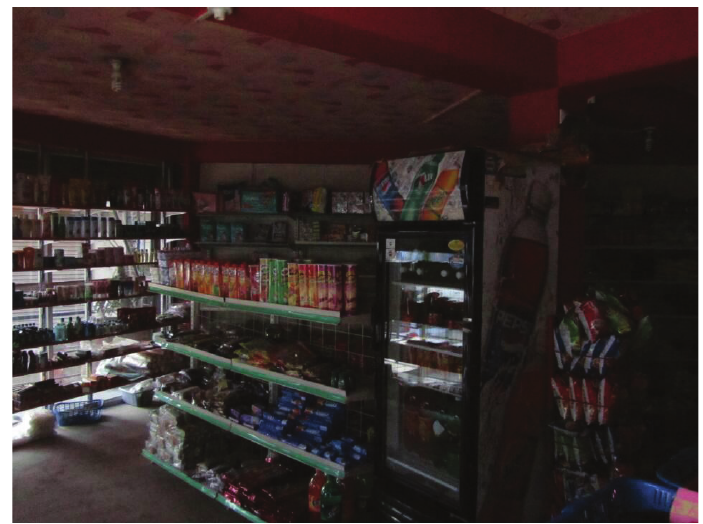
Figure 4. This photo was taken from a super-shop in Janakpurdham district in Nepal. Janakpurdham is known for many historical and religious sites and has very little traces of industrialization. Photo credit: Mr. Sudeep